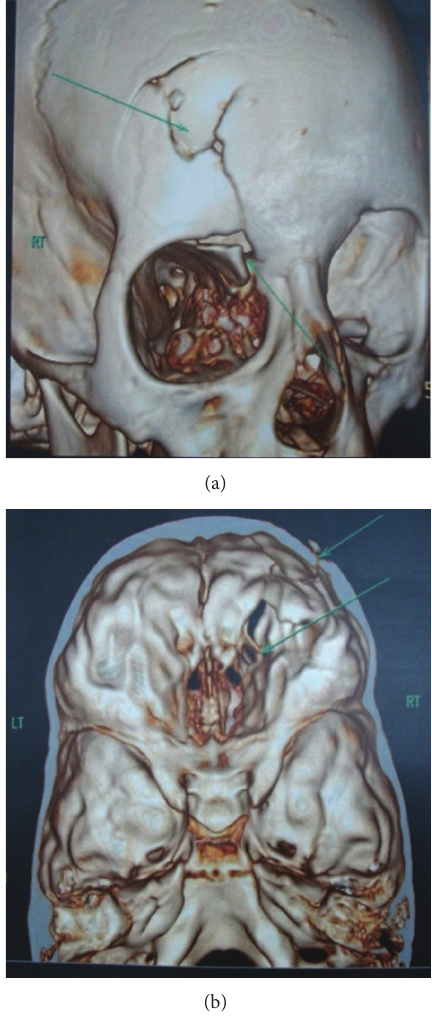
Figure 2: 3D CT scan revealed depressed fracture involving the frontal bone on the right side, right parietal bone, right superior orbital margin, right lamina papyracea, right maxillary, bilateral ethmoid, sphenoid sinusitis/hemosinus, and small posttraumatic encephalocele at anterior skull base from cribriform